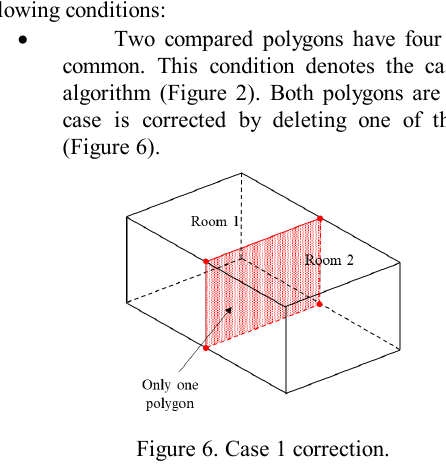
Figure 6. Case 1 correction.